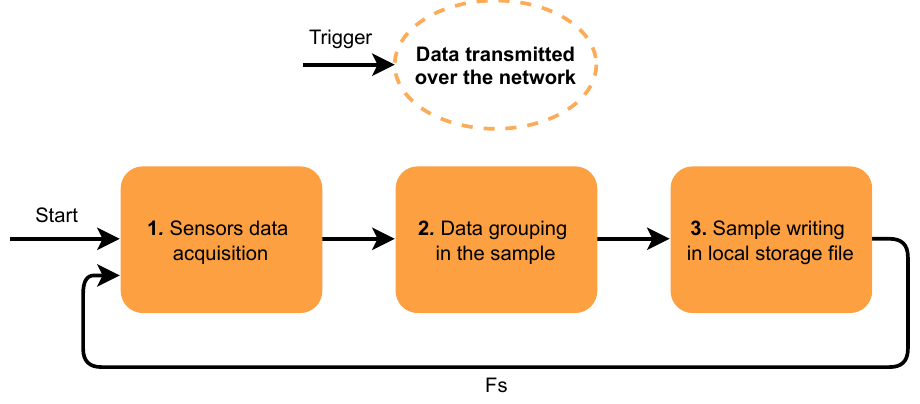
Figure 3. iBikeSafe sensing unit state